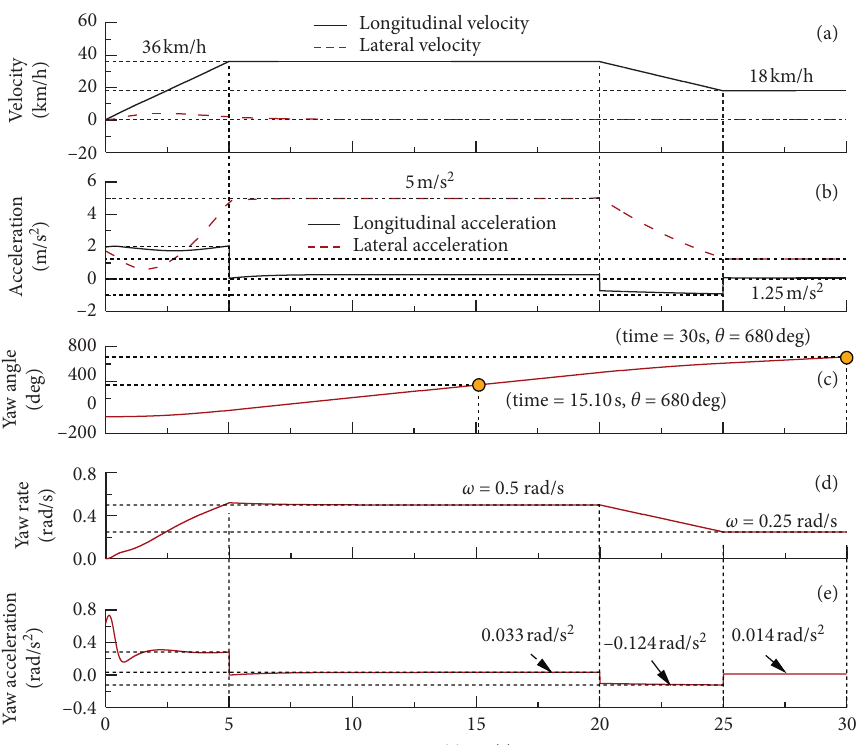
Figure 12: Time histories for several state variables of the vehicle in the circular path-following motion: (a) velocity, (b) acceleration, (c) yaw angle, (d) yaw rate, and (e) yaw